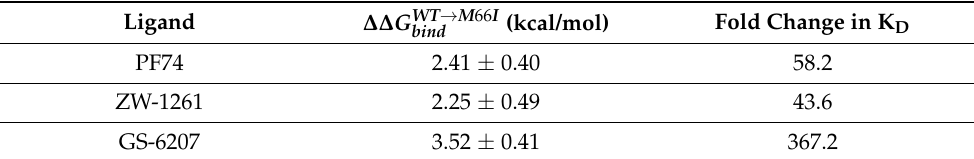
Table 2. Changes in the ligand binding free energies caused by the M66I CA mutation for the antivirals PF74, ZW-1261, and GS-6207.